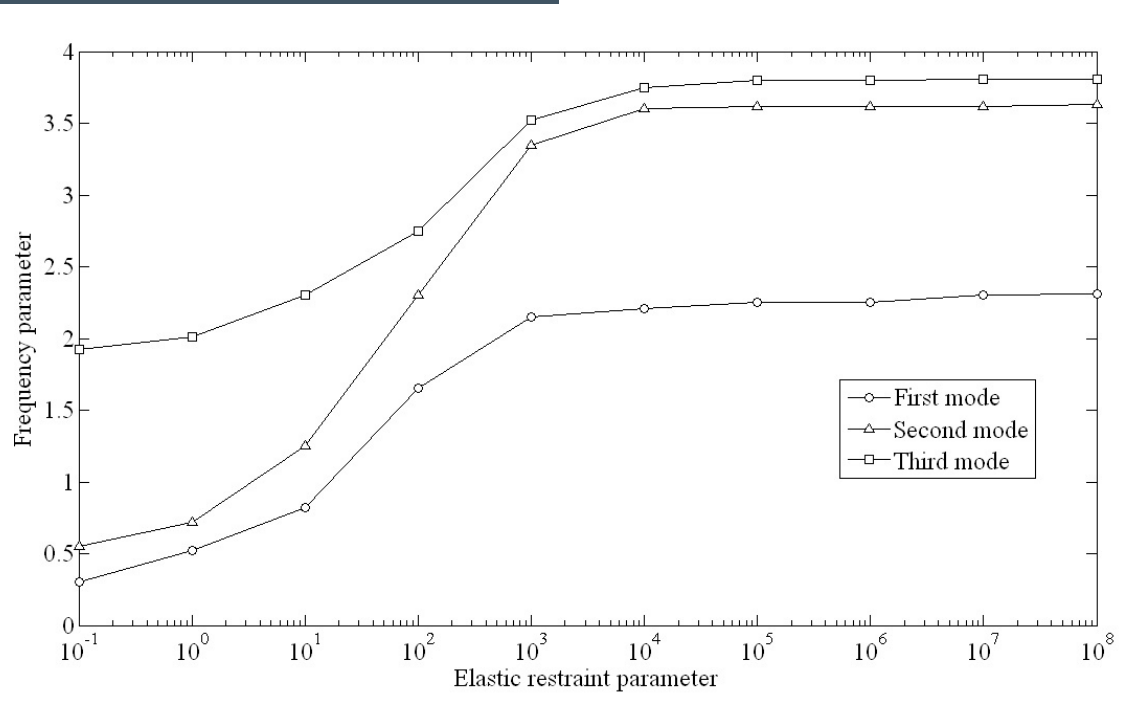
Figure 2. Fundamental frequencies parameter for a cross-ply laminated plate with one edge clamped and other three edges elastically support ( h/a = 0 . 1 )